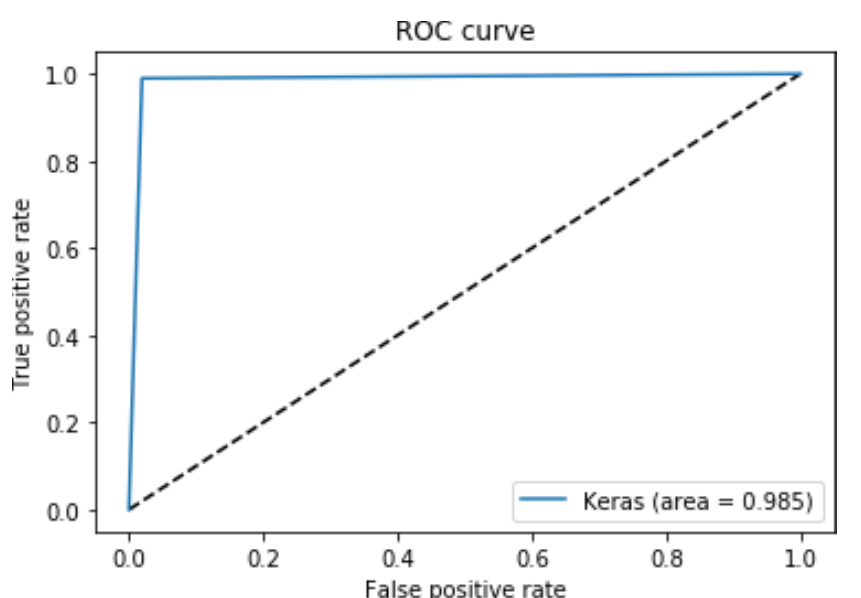
Figure 9: ROC curve for 80% training using LSTM in time